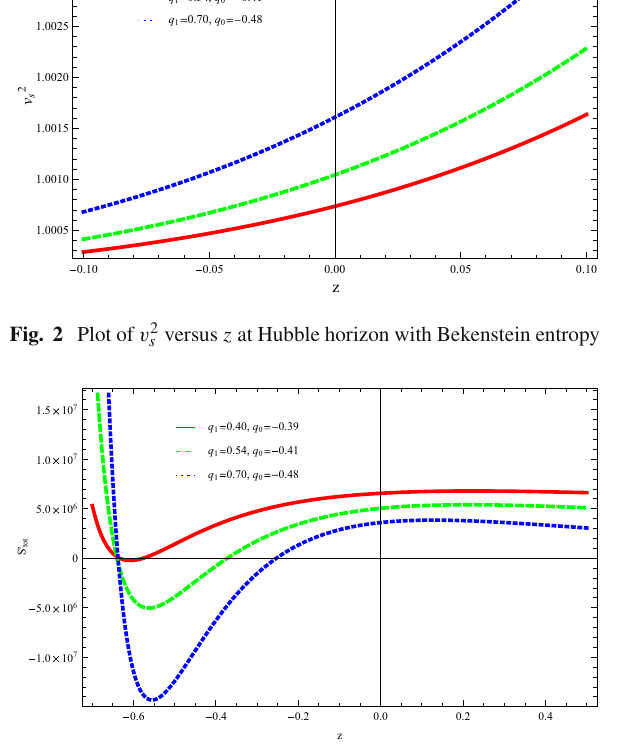
Fig. 3 Plot of S (cid:5) tot versus z at Hubble horizon with Bekenstein entropy